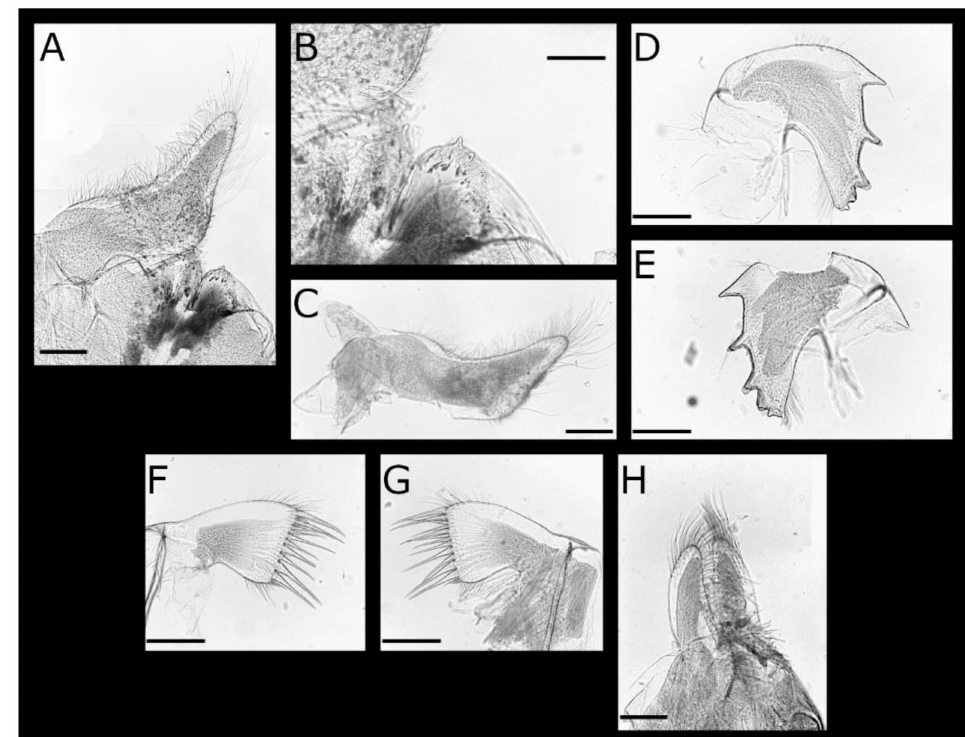
Figure 14. Euacasta excoriatrix sp. nov. mouthparts (A,B, WAM C71800, holotype; C–H, WAM C61475 paratype). ( A ) labrum with right mandible palp; ( B ) crest of labrum; C, right mandible palp; ( D , E ) left and right mandible; ( F , G ) left and right maxillule; ( H ) left and right maxillae. Scale bars: A, C–H = 200 µ m; B = 100 µ m.